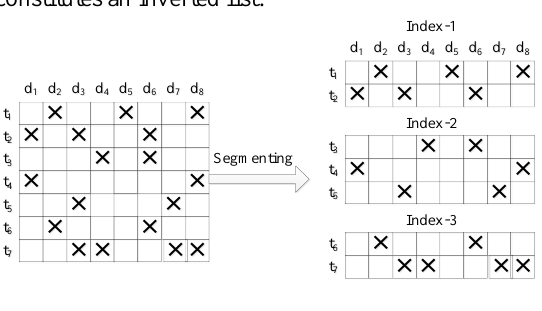
Figure 4. Inverted index partitioning based on